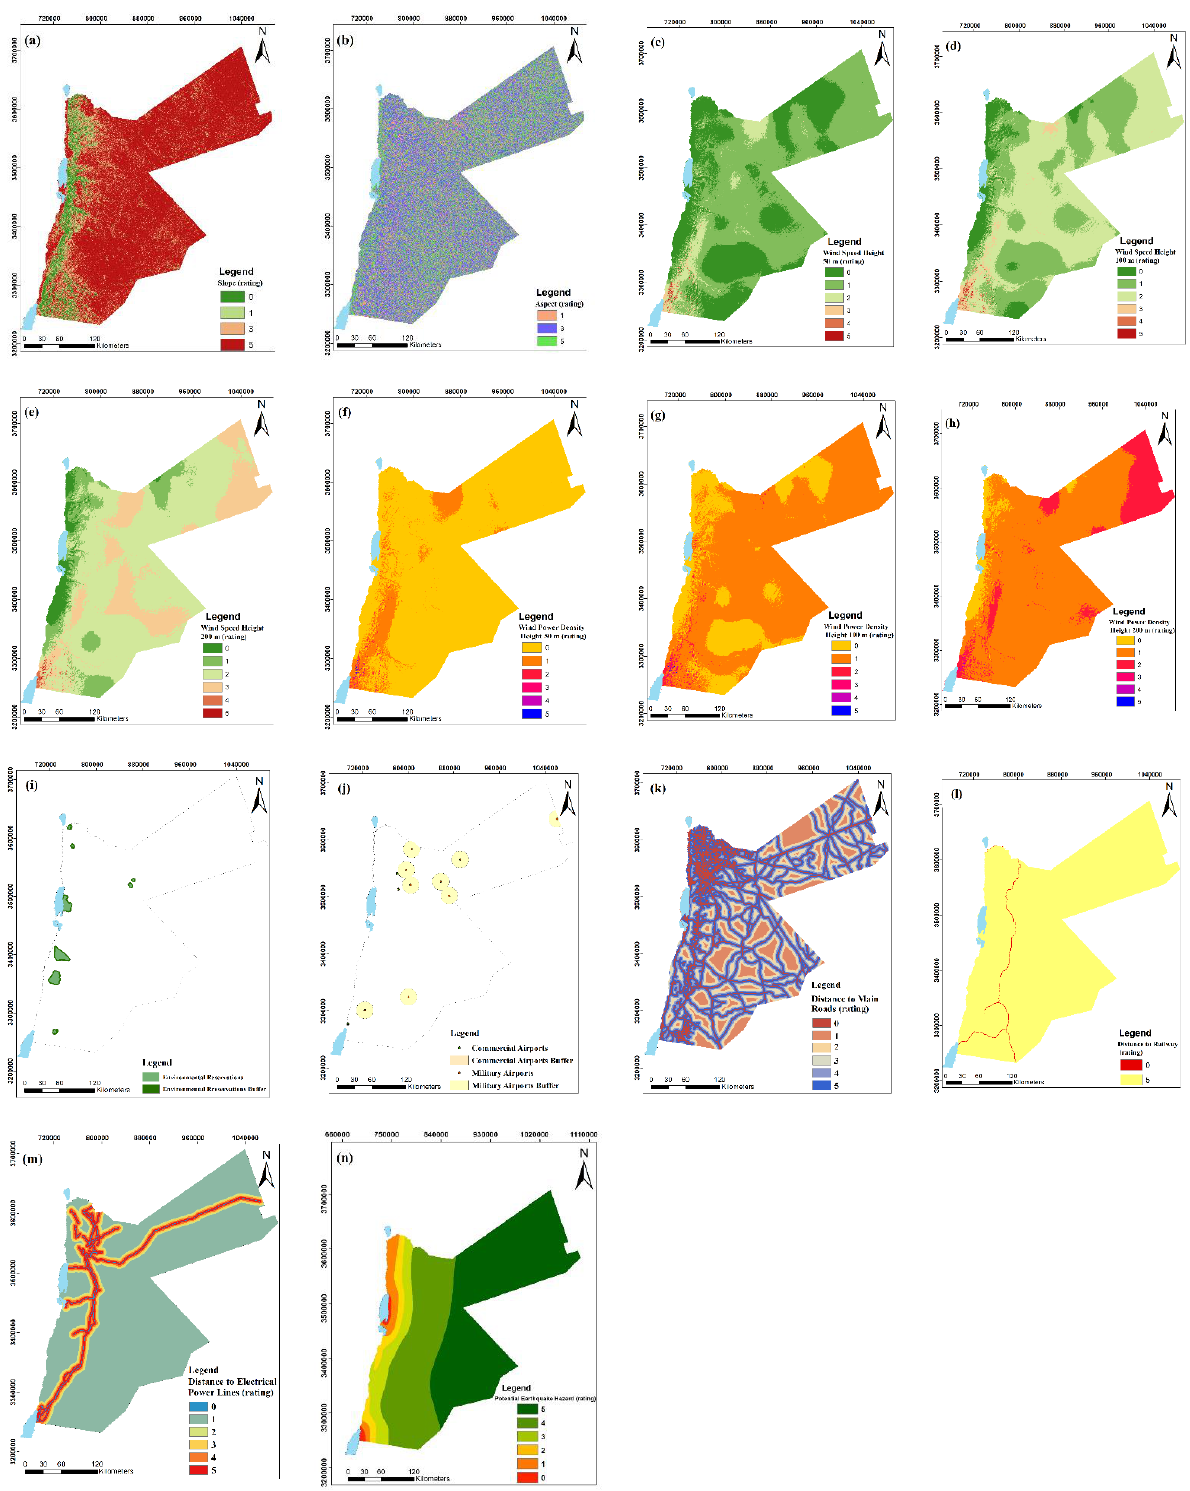
Figure 3. Rating maps of ( a ) Slope Map, ( b ) Aspect Map, ( c ) Wind Speed (m/s) at a height of 50 m Map, ( d ) Wind Speed (m/s) at a height of 100 m Map, ( e ) Wind Speed (m/s) at a height of 200 m Map, ( f ) Wind Power Density (W/m 2 ) at a height of 50 m Map, ( g ) Wind Power Density (W/m 2 ) at a height of 100 m Map, ( h ) Wind Power Density (W/m 2 ) at a height of 200 m Map, ( i ) Environmental Reserves Buffer Location Maps, ( j ) Airports Buffer Location Map, ( k ) Euclidean Distance Main Road Map, ( l ) Euclidean Distance Railway Map, ( m ) Main Electrical Power Lines Map, ( n ) Potential Earthquake Hazard